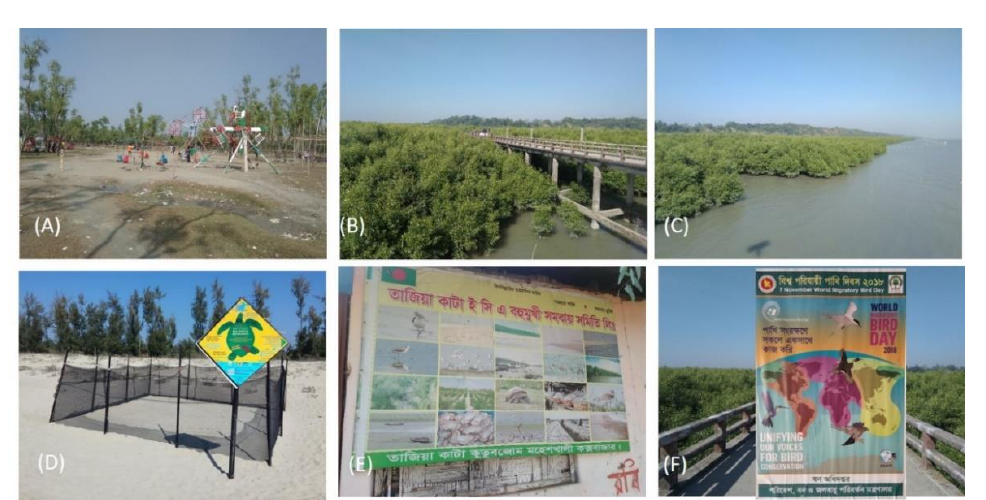
Figure 4. Cultural ecosystem services, public awareness, and conservation initiatives in the studied areas of the south-eastern coast of Bangladesh: ( A ) Tourism spot with reactional facilities; ( B ) concrete foot trail in the planted mangrove patch in Moheskhali; ( C ) incredible natural scenic beauty of the planted mangrove forest along the Moheskhali channel; ( D ) sea-turtle conservation initiatives on Sonadia Island and Moheskhali developed by NGOs for protecting turtle eggs and facilitating hatching; ( E ) public conservation awareness initiates achieved through placing billboards; ( F ) posters for bird conservation in public places (Photo credit: Shuvo